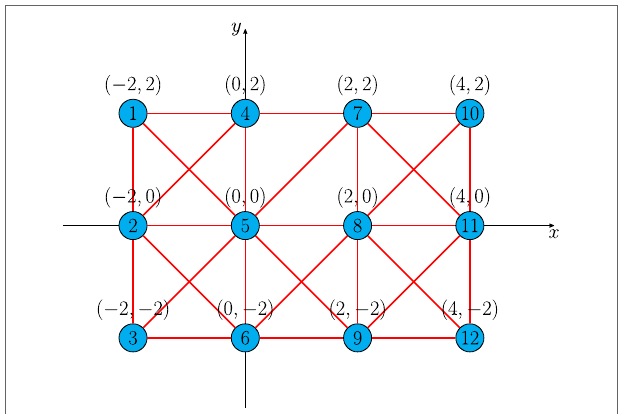
FIGURE 12 | Communication graph of the active-passive sensor network in Example 4 with 12 nodes (lines denote communication links, circles denote